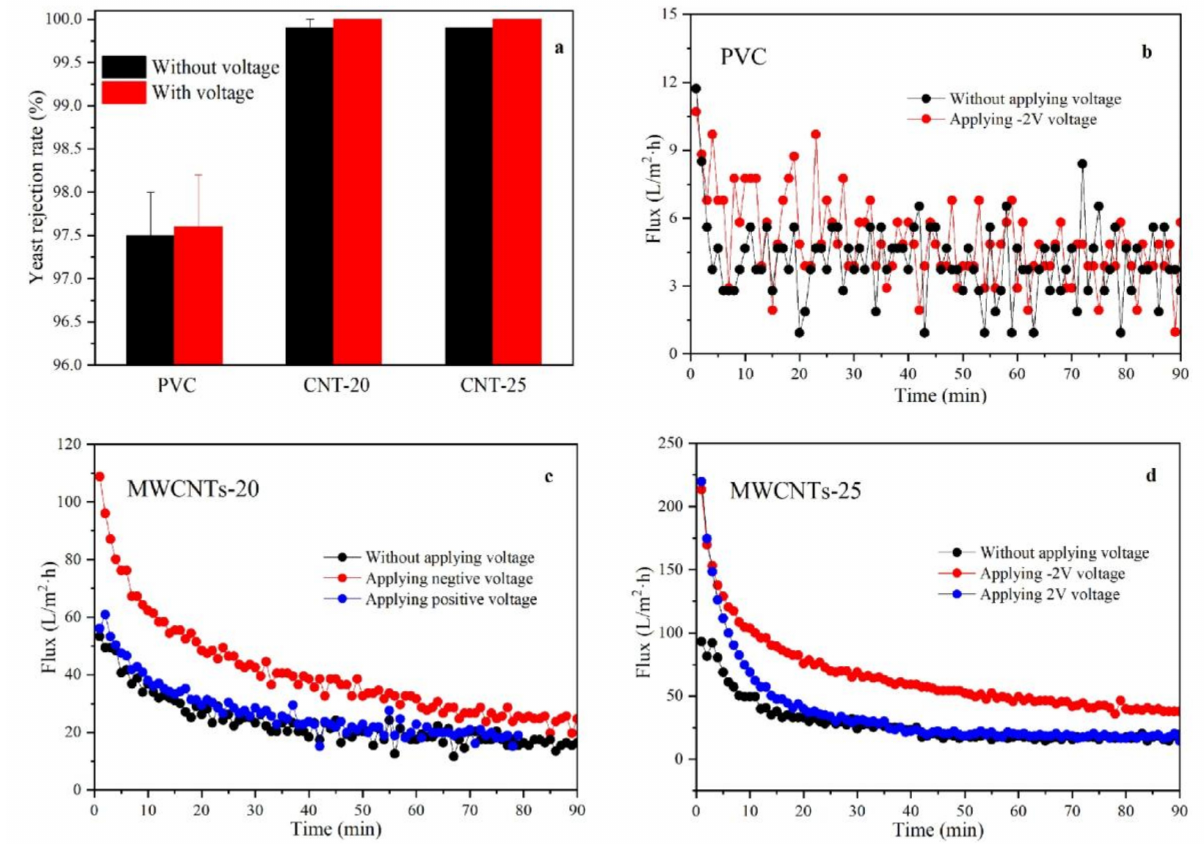
Figure 9. Yeast rejection tests using different membranes ( a ). Water flux variation vs. time using PVC membrane ( b ), MWCNTs-20 membrane ( c ), and MWCNTs-25 ( d ). Both the water flux values without and with applying voltage are